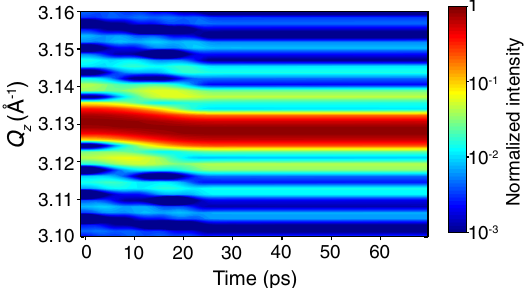
FIG. 10. Simulated diffraction profiles corresponding to the hypothetical case of a single strain pulse produced by depolari- zation-field screening in the PTO/STO SL, in the absence of the strain pulse arising from the photoacoustic excitation of the SRO